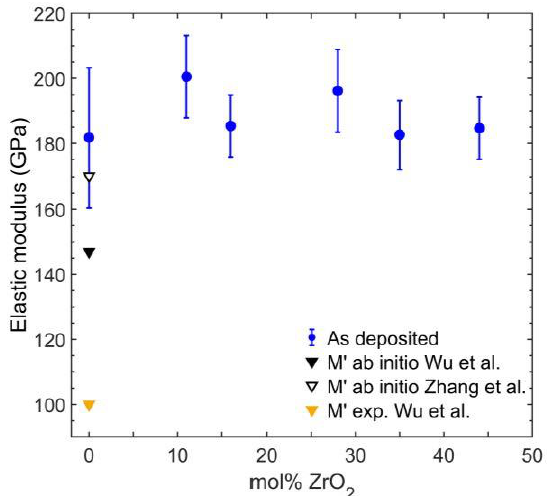
Figure 10. Elastic modulus measured by nanoindentation as a function of ZrO 2 content for as-deposited coatings (blue). Black symbols indicate ab initio calculated elastic moduli by Wu et al. (filled symbol) [44] and Zhang et al. (open symbol) [14] for M’. Experimental results by Wu et al. [44] are shown in orange.